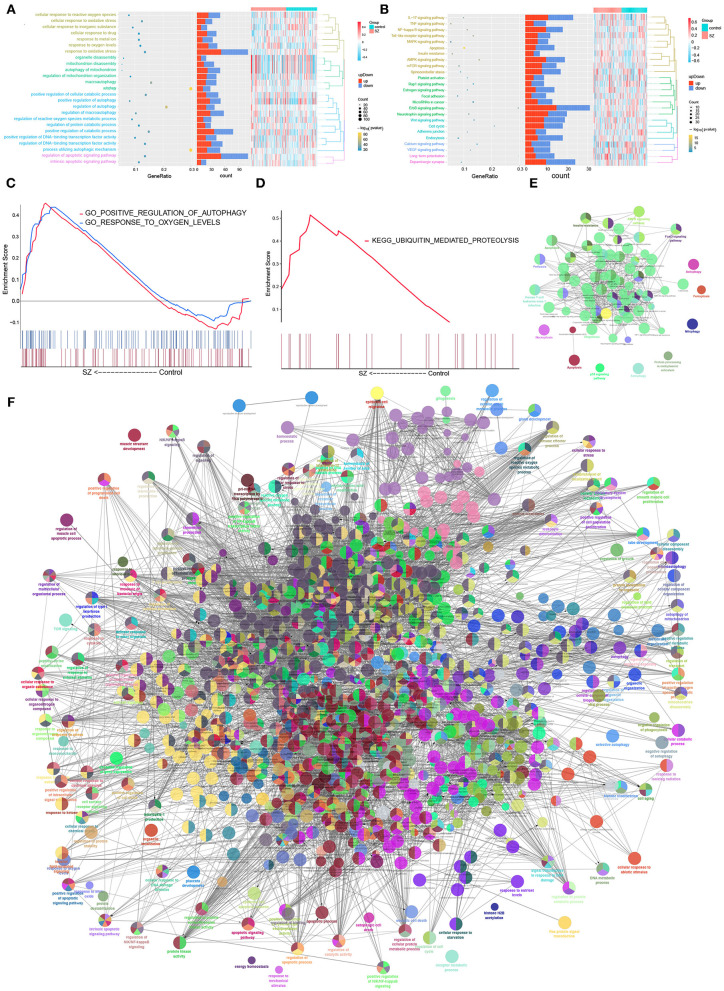
Biological functions and KEGG pathways involving autophagy-related DEmRNAs in schizophrenia (SZ). (A) Biological processes involving autophagy-related DEmRNAs. (B) Kyoto Encyclopedia of Genes and Genomes (KEGG) pathways involved in autophagy-related DEmRNAs. (C) Biological processes involving autophagy-related DEmRNAs. (D) KEGG pathways involved in autophagy-related DEmRNAs. (E) Pathway enrichment analysis of 375 autophagy-related DEmRNAs using ClueGO. (F) Biological enrichment analysis of 375 autophagy-related DEmRNAs using ClueGO. Each node represents a biological process or KEGG pathway. Edges represent connections between the nodes, and the length of each edge reflects the relatedness of two processes.